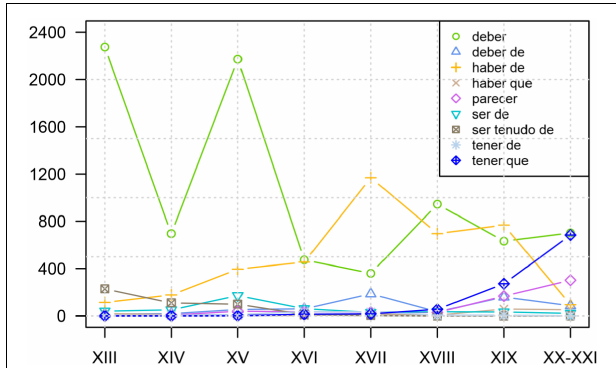
FIGURE 4 | Evolution of the relative frequencies (per million words) of nine Spanish modal constructions with an infinitive, all of them deontic except with parecer “to seem” (elaboration by Malte Rosemeyer using data from various members of the GRADIA project: reproduced by kind permission of the author). The data were recovered from the GRADIA corpus: